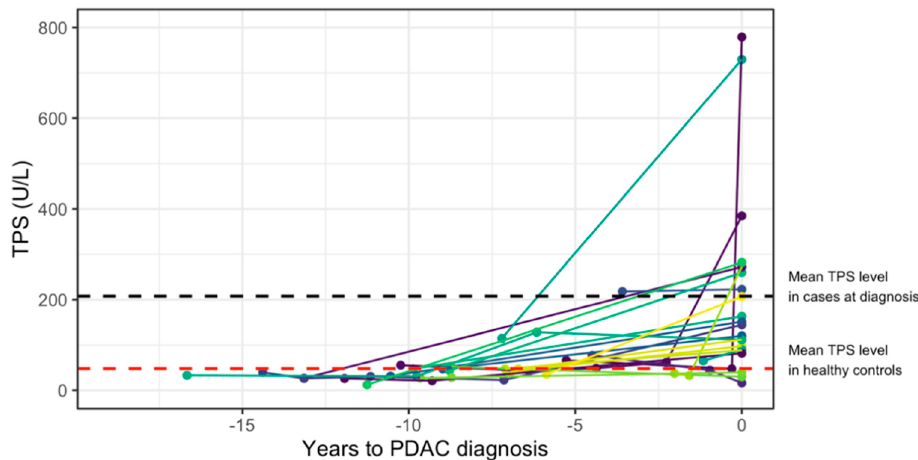
Figure 4. Longitudinal TPS plasma levels. Spaghetti plot of longitudinal plasma samples available at time of PDAC diagnosis and years before diagnosis in 22 individuals. The TPS levels are shown on the y -axis, and years until PDAC diagnosis are shown on the x -axis. Each line combines samples taken from the same individual. Time to diagnosis is presented as negative values for visual purposes.